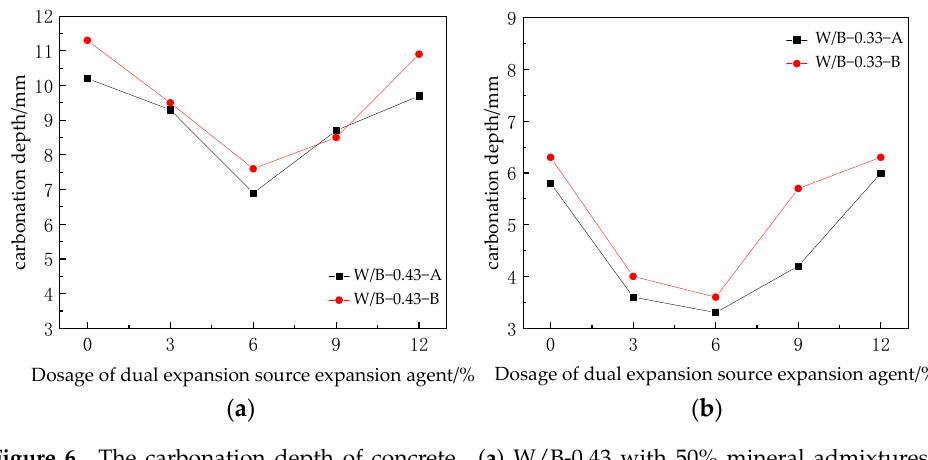
Figure 6. The carbonation depth of concrete. ( a ) W/B-0.43 with 50% mineral admixtures, ( b ) W/B-0.33 with 50% mineral admixtures.